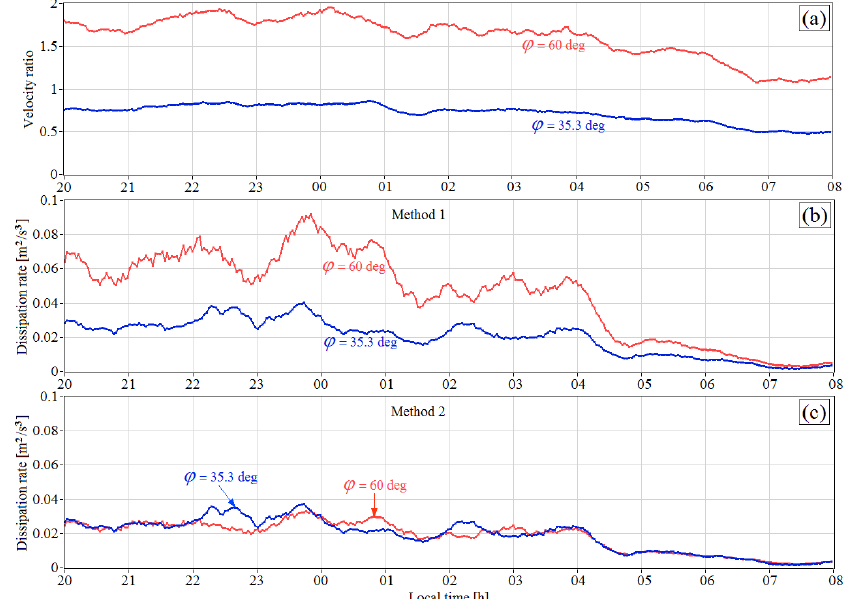
Figure 3. Time series of the ratio of the mean wind velocity to the linear scanning speed µ ( a ) and estimates of the turbulent energy dissipation rate obtained by Methods 1 ( b ) and 2 ( c ) at a height of 70 m. Scanning at an elevation angle of 35.3° (blue curves) and 60° (red curves). Measurements were taken at the BEO from 19:40 LT of 23 July 2018 to 08:20 LT of 24 July 2018.